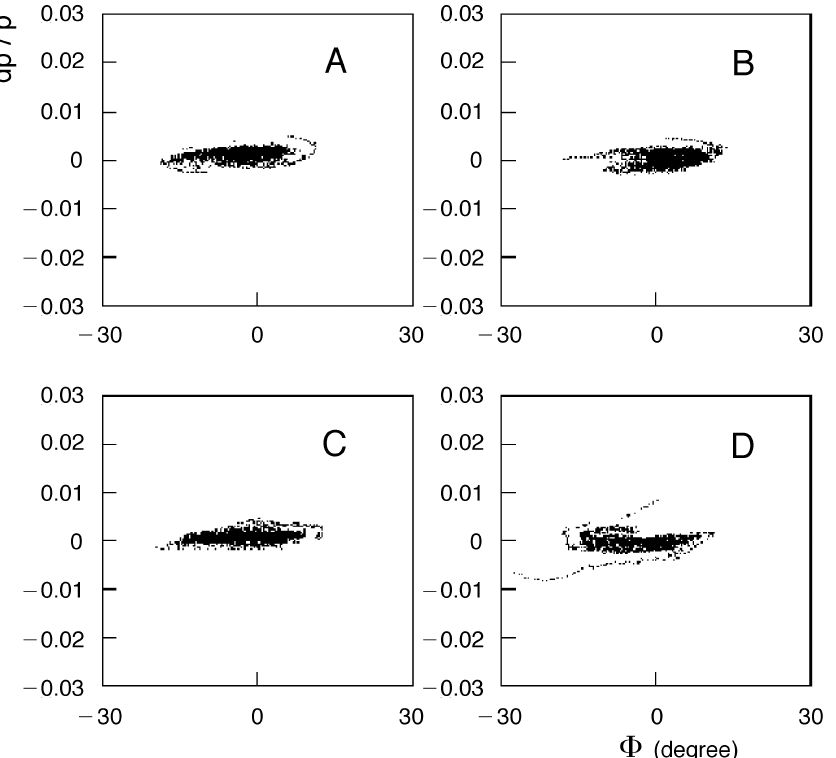
FIG. 40. Recirculating linac accelerator simulation results with wake fields, with beam accelerated from 200 to 2000 GeV in a ten-turn recirculating linac accelerator. Longitudinal phase space plots for different bunch charges: (A) very small number, (B) 0.83 3 10 12 , (C) 2.08 3 10 12 , and (D) 4.17 3 10 12 muons in a